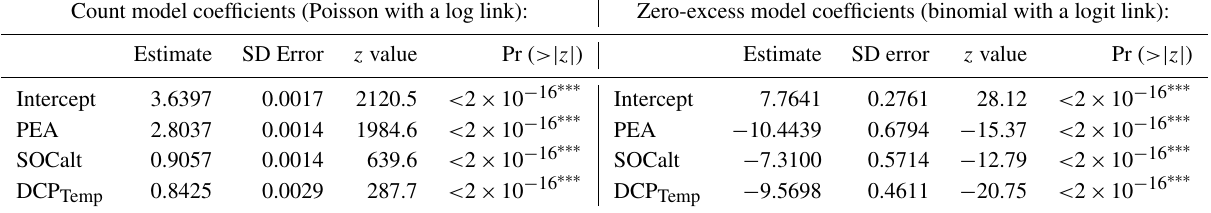
Table 3. Regression coefficients of GLMzip3. Count model coefficients (Poisson with a log link): Zero-excess model coefficients (binomial with a logit